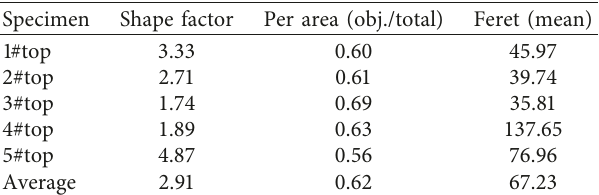
Table 5: Pore structure parameters of the aerated concrete block (middle).